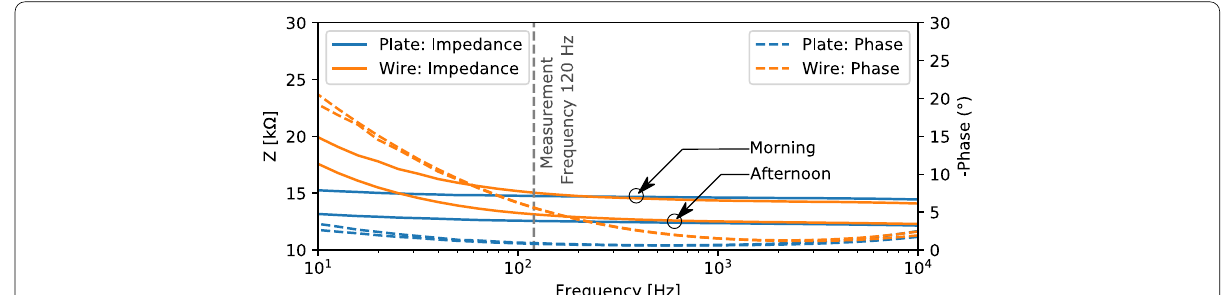
Fig. 9 Impedance and phase angle in dependence on the frequency of the internal resistance of the RE determined while placing the RE on a stainless steel plate or with the stainless steel wire (see Fig. 5 Nr.4) through the sponge at the tip of the